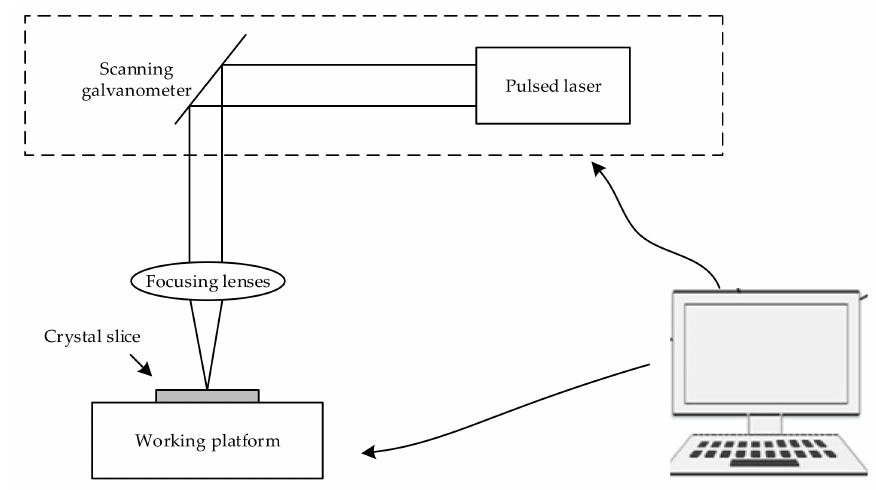
Figure 1. Schematic diagram of laser processing for frequency modulation.